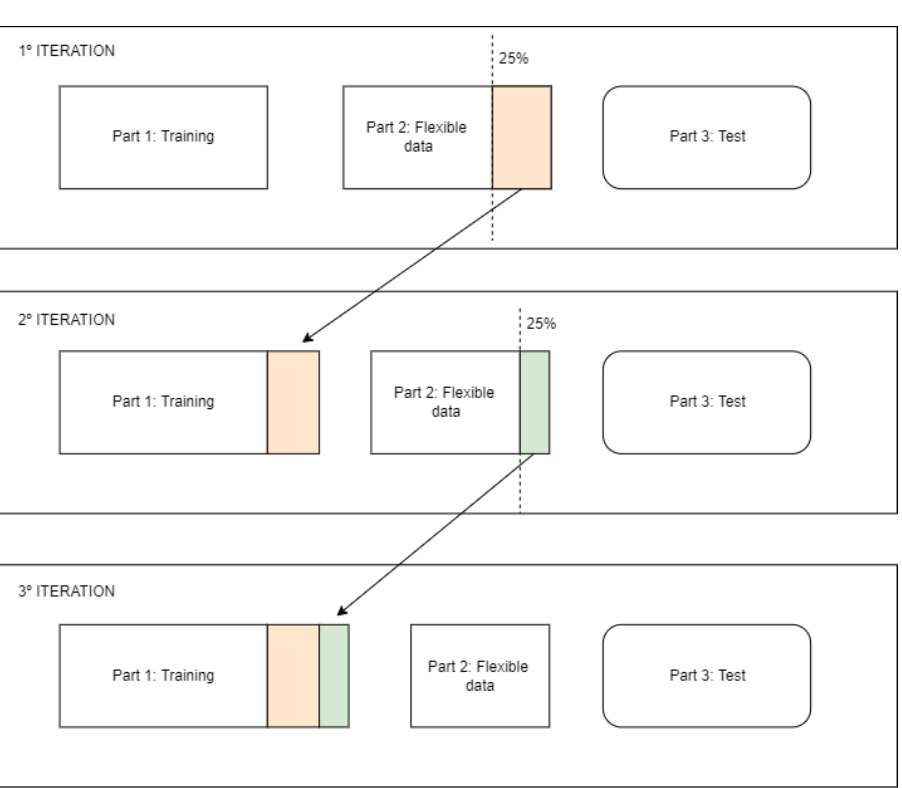
Figure 1. RL-SSI Data